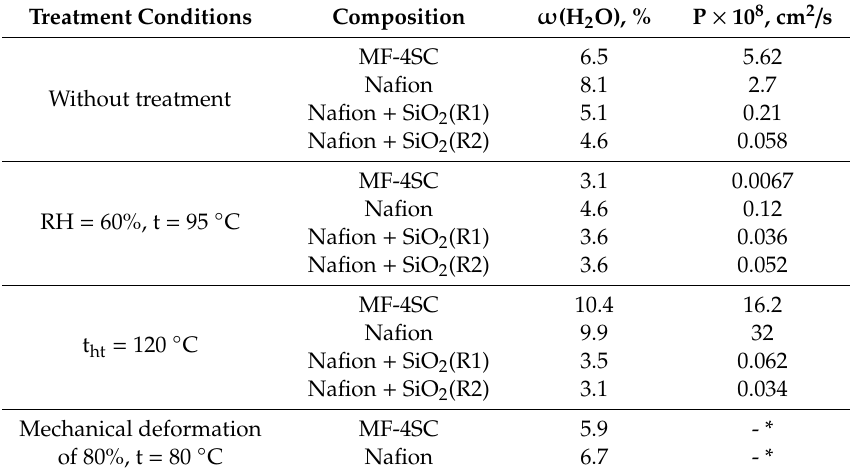
Table 2. The water uptake of membranes and the di ff usion permeability of 0.1 M KCl solution into water through membranes in the K + -form (samples obtained by in situ).